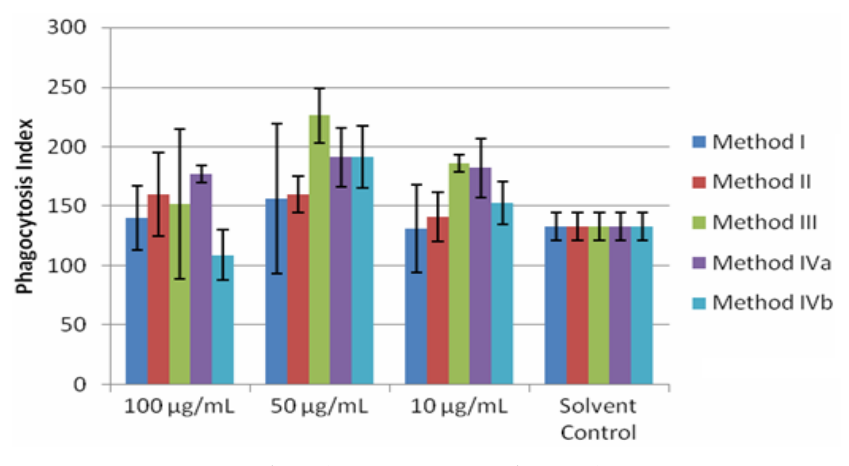
Figure 2. Phagocytic Index of the polysaccharide-rich fractions (n=3)